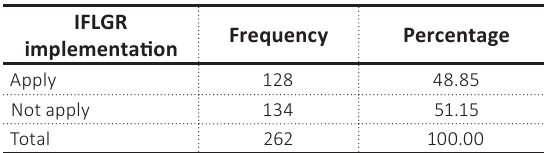
Table 3. IFLGR implementation